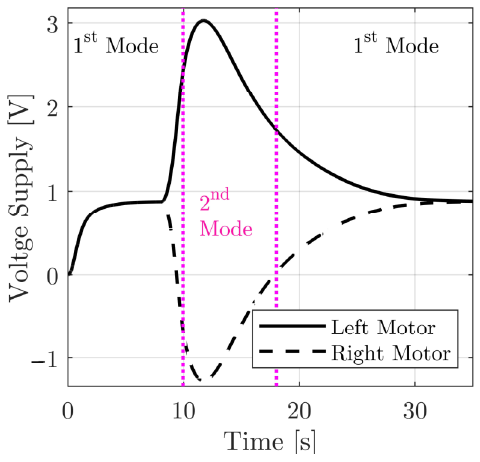
Figure 8. Voltage Figure 8. Voltage supplies.